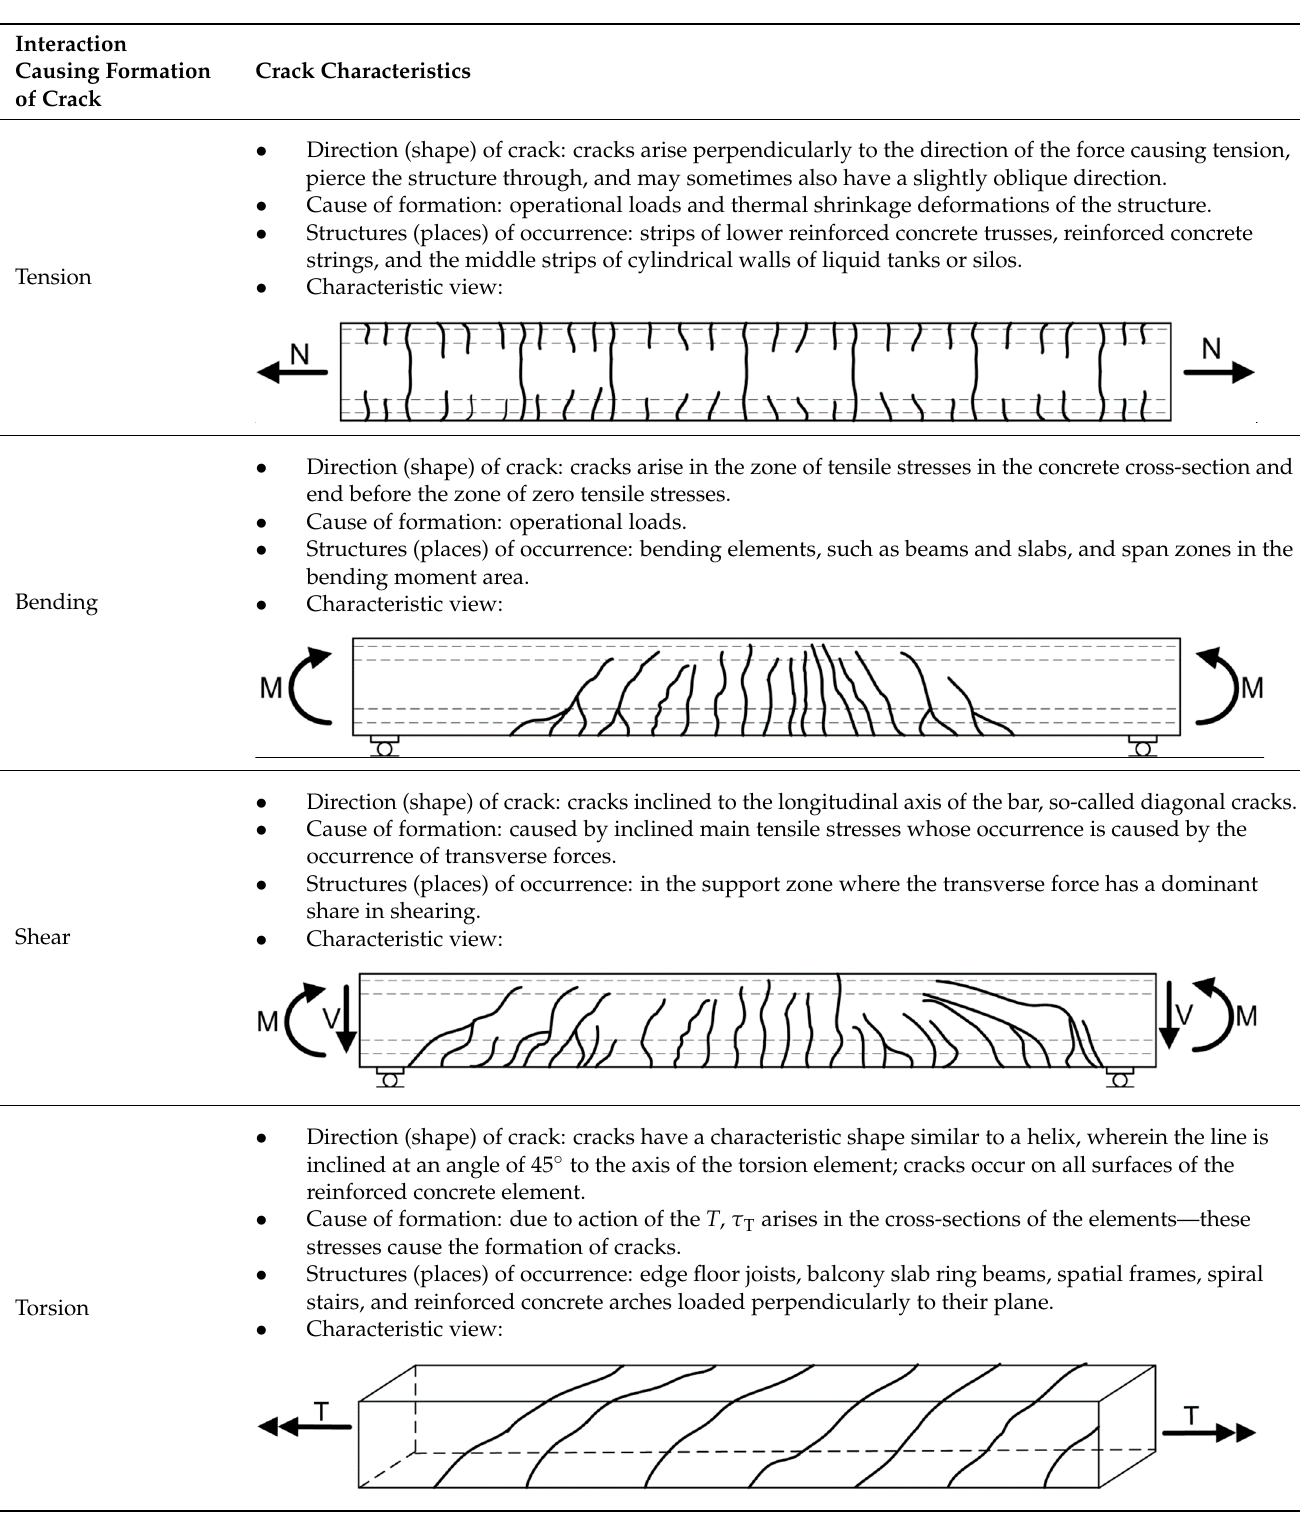
Table 4. Summary of relevant data corresponding to cracks in reinforced concrete structures resulting from various interactions; N , M , V , T —description in the